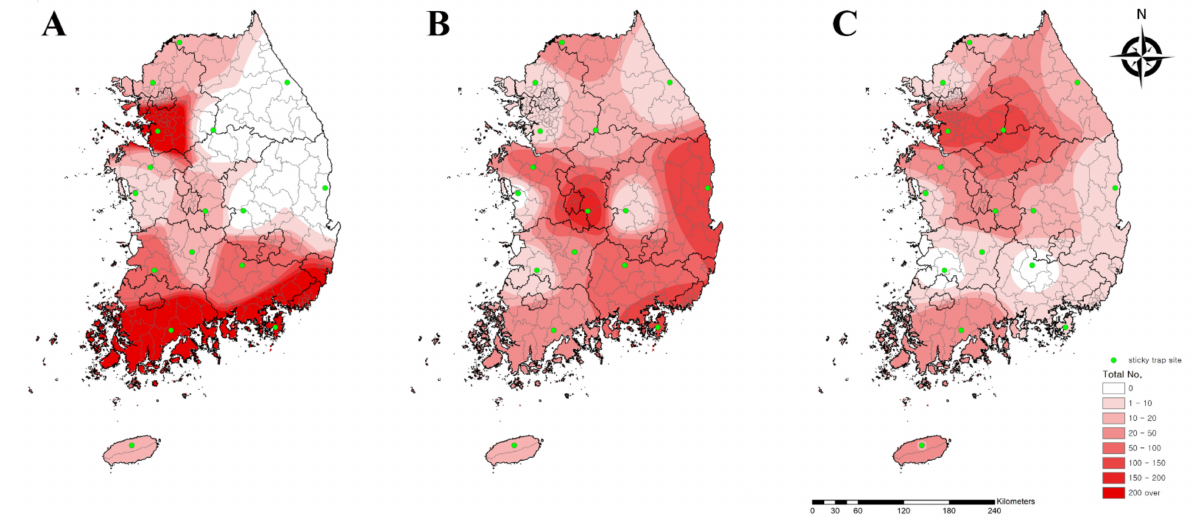
Figure 2. Geographical distribution of three major chigger mite species carrying Orientia tsutsugamushi . ( A ) Leptotrombidium scutellare , ( B ) L. palpale , and ( C ) L. pallidum were collected from sticky traps at 16 collection sites nationwide in the Republic of Korea in 2020. The map color indicates the total number (0 to >200). Sticky traps are denoted by green